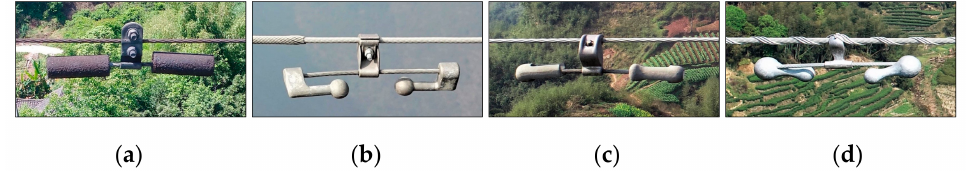
Figure 2. Four common types of vibration dampers: ( a ) FD; ( b ) FDZ; ( c ) FDY; ( d ) FFH.